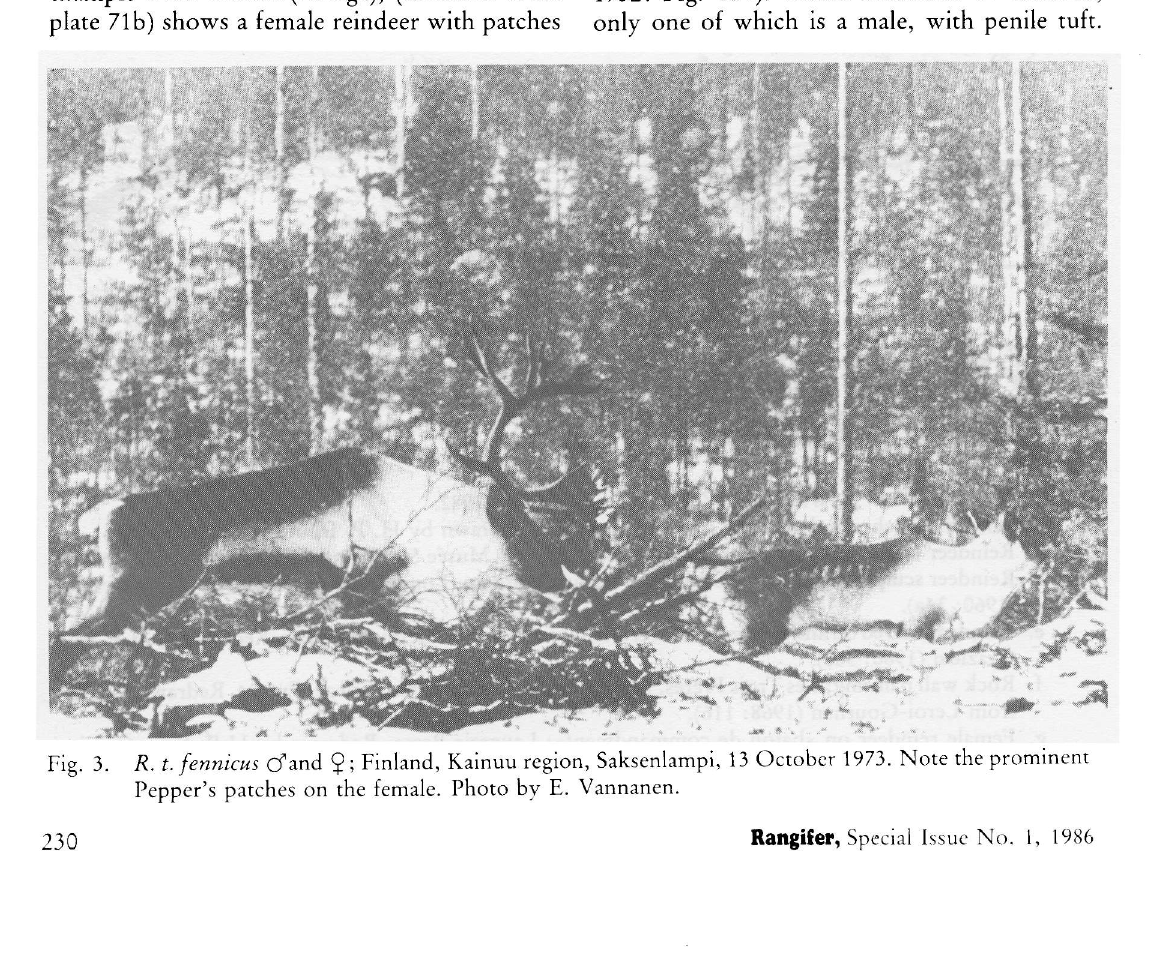
R. t. fenmcus cf and $ ; Finland, Kainuu region, Saksenlampi, 13 October 1973. Note the prominent Pepper's patches on the female. Photo by E.